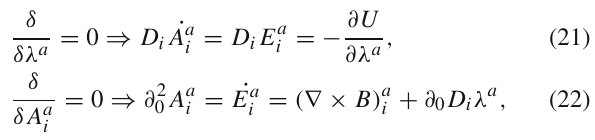
Fig. 3 The modifications to the i-j